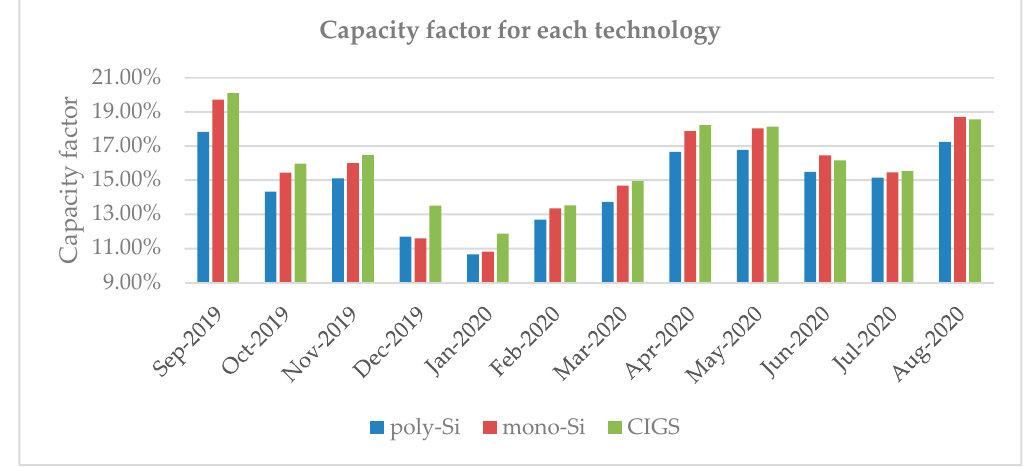
Figure 11. Capacity factor for each technology.